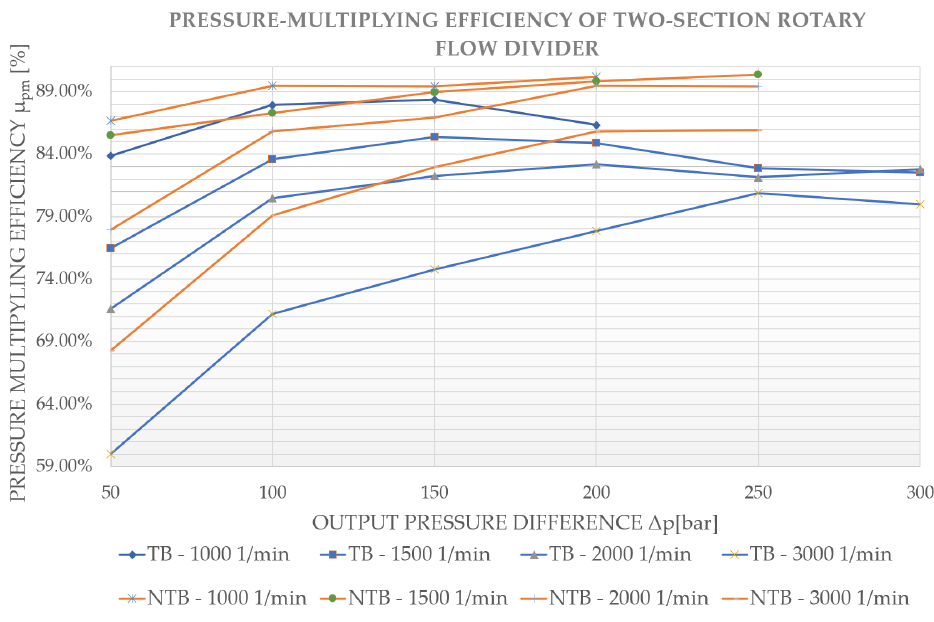
Figure 6. Pressure multiplying